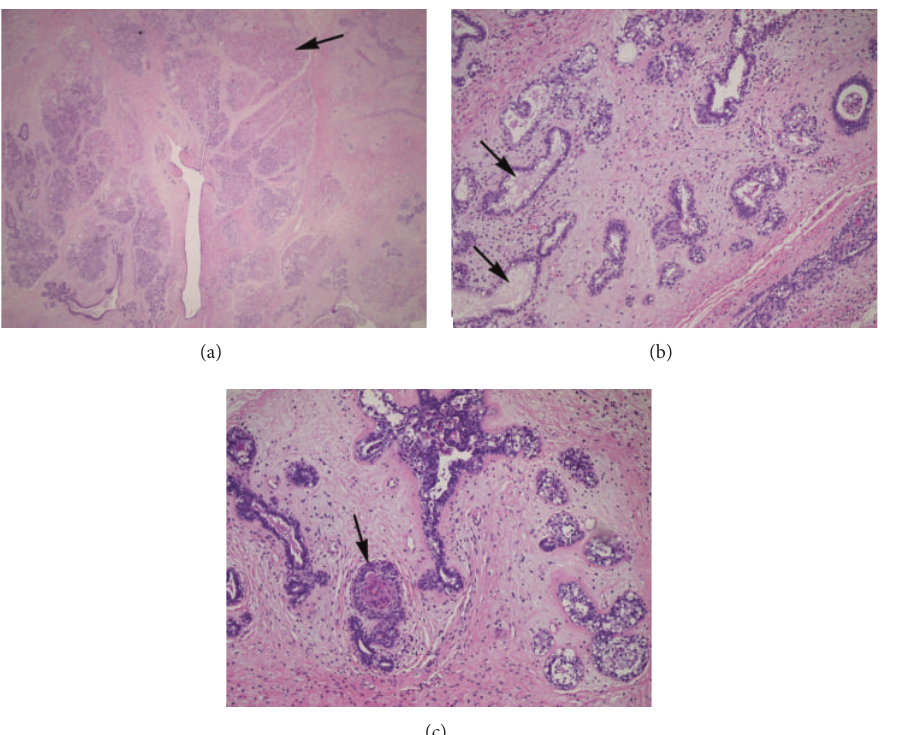
Figure2:Histologyslidesofthelesionshow(a)lobulararchitectureandassociatedischemicnecrosis(arrow).(b)Epithelialandmesenchymal proliferation with apocrine change (arrow). (c) Focal squamous metaplasia (arrow). Images were acquired using H&E staining with 40x (a) and 100x ((b), (c))